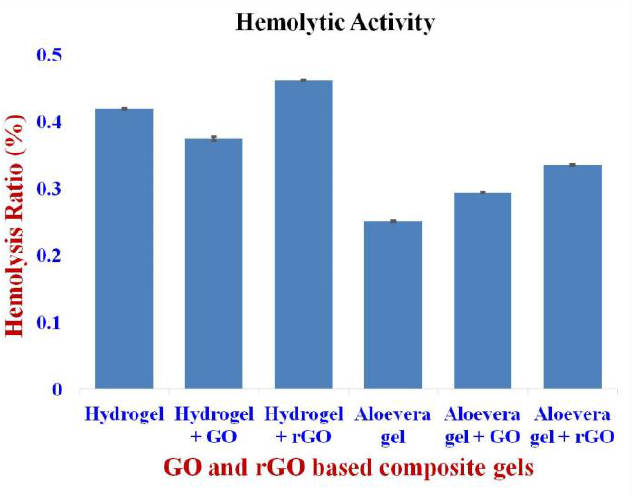
Figure 9. Hemolytic activity of GO and rGO-based composite gels. The hemolytic activity of the GO and rGO-based formulations showed an accepted hemolytic value of less than 2%.